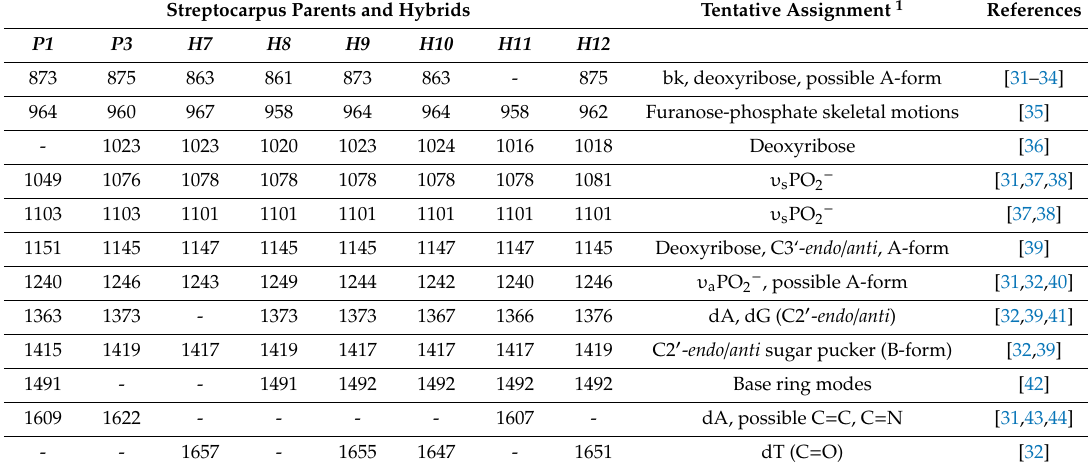
Table 5. Peak positions (cm − 1 ) and tentative assignments of FT-IR absorbance bands for DNA from the Streptocarpus P1 × P3 parental cross and their corresponding hybrids.